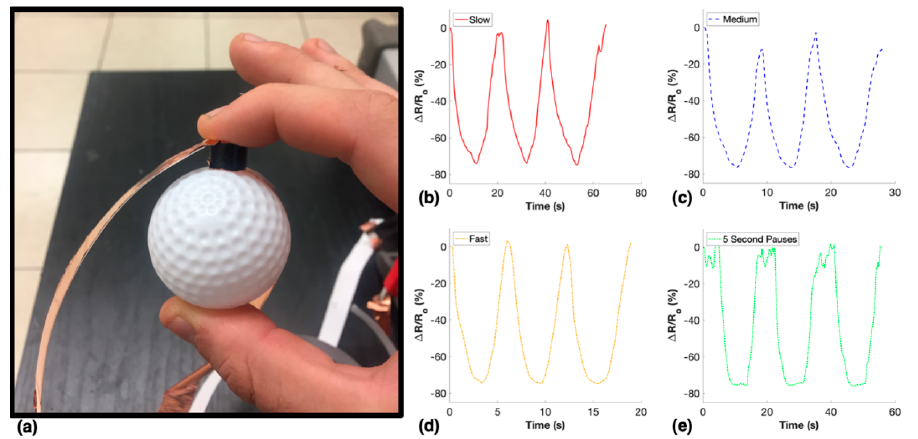
Figure 10. Sensing application of 2.5 wt. % porous nanocomposite: ( a ) experimental setup and sensing functions during various squeezing rates including: ( b ) slow, ( c ) medium, ( d ) fast, and ( e ) 5 s pauses at maximum and minimum compression.